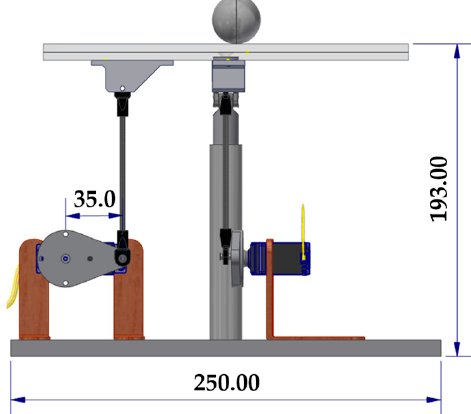
Figure 3. Ball-on-plate system dimensions [mm].